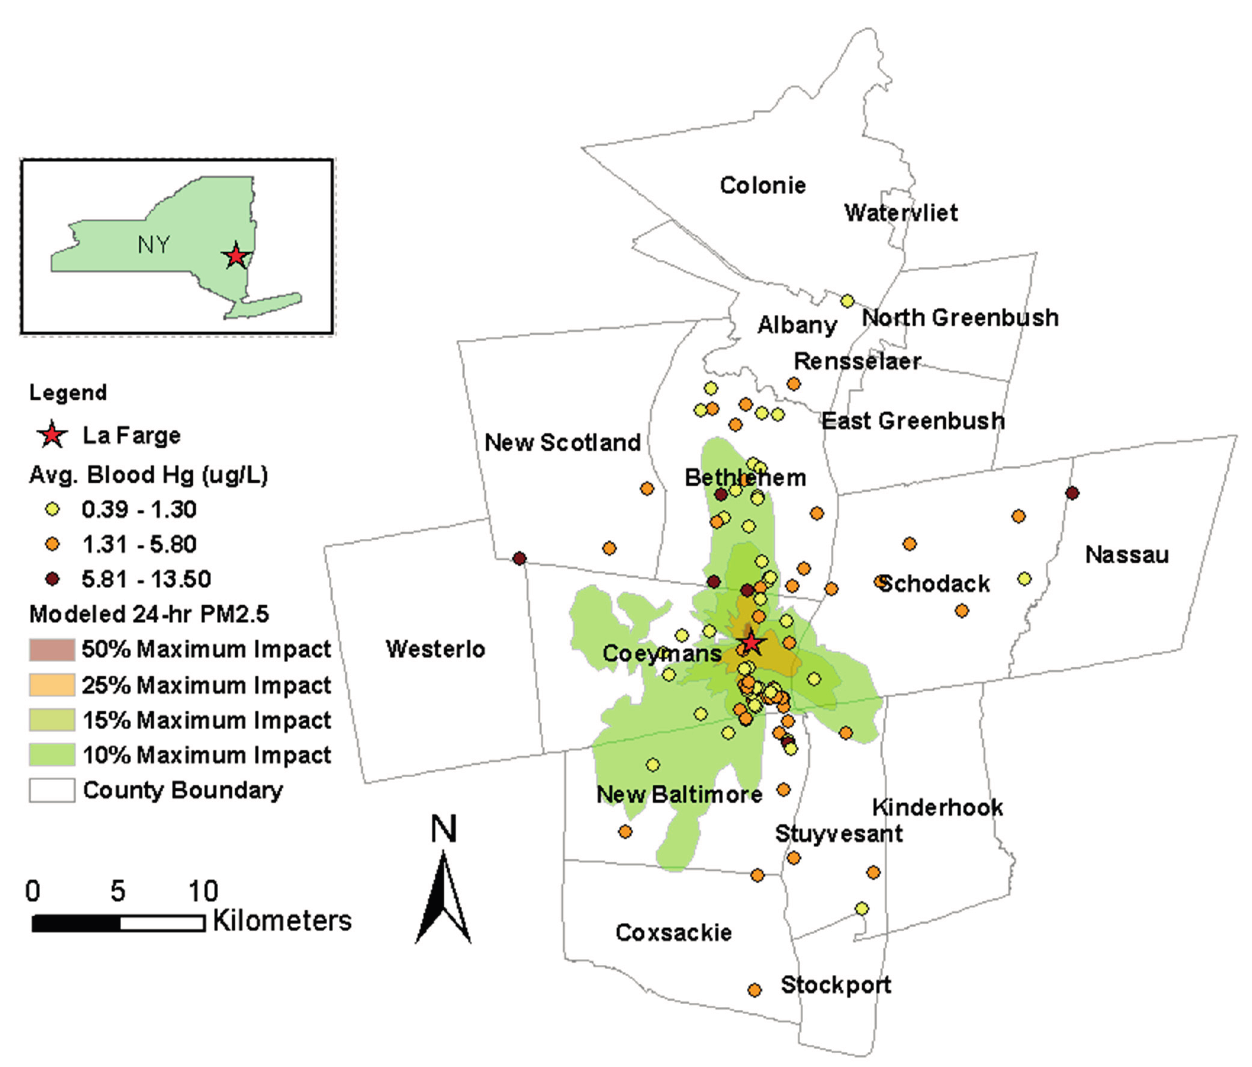
Figure 1. Map of the Ravena study area, showing the location of LaFarge Cement Plant, 24-h PM 2.5 contours modeled by New York State Department of Health (NYS DOH) [19], and average blood mercury (Hg) in each